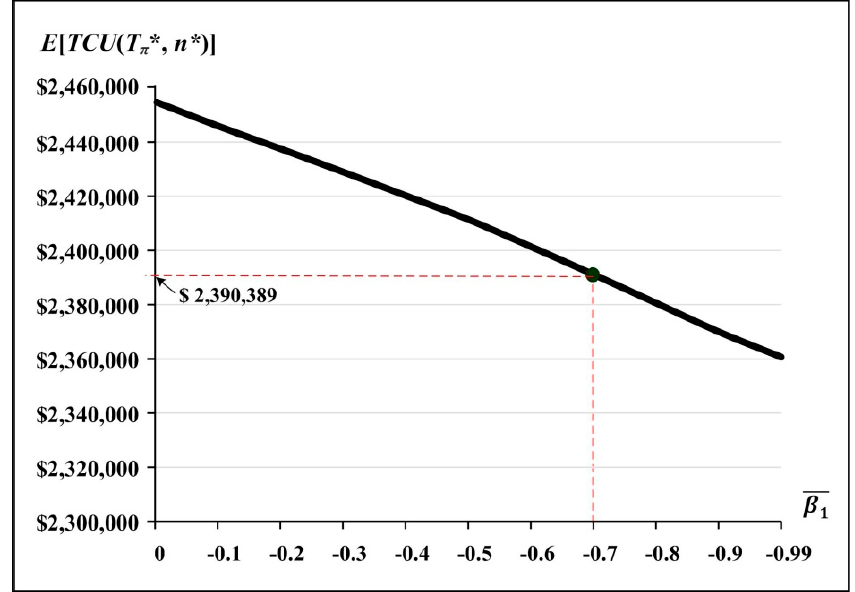
Figure 7. Impact of differences in 𝛽 (cid:2869) (cid:3364)(cid:3364)(cid:3364) on E [ TCU ( T π *, n *)]